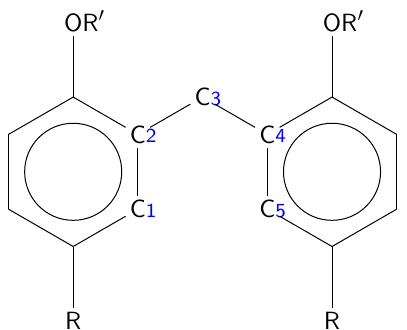
Figure 1. Dihedral angles between adjacent aryl groups of a calixarene. The first dihedral angle is defined through atoms 1–4, and the second one–through atoms